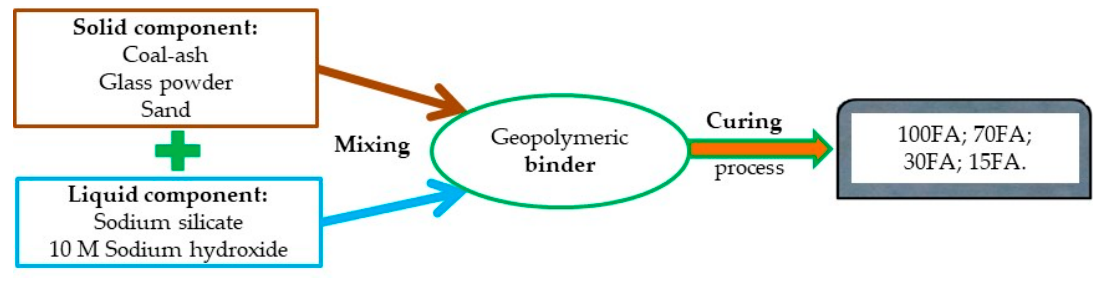
Figure 1. Process flow diagram of sample obtaining.